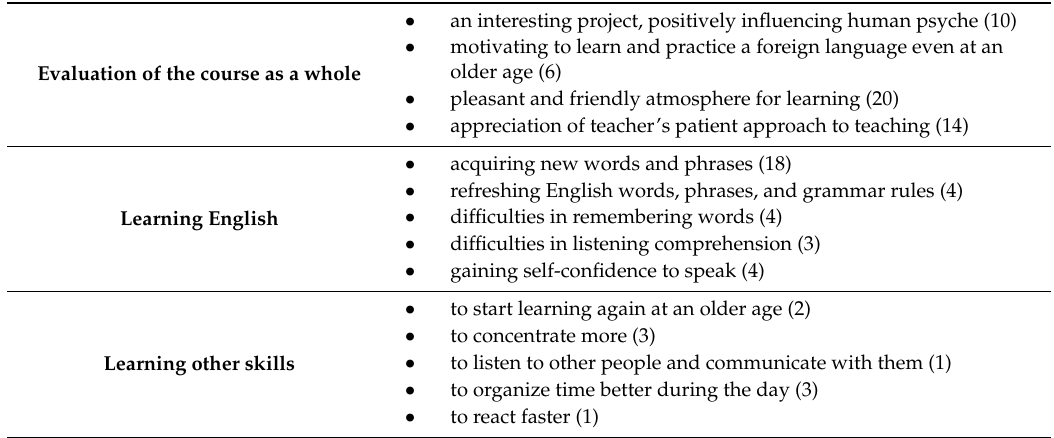
Table 3. Findings from the participants’ reflections and the number of participants